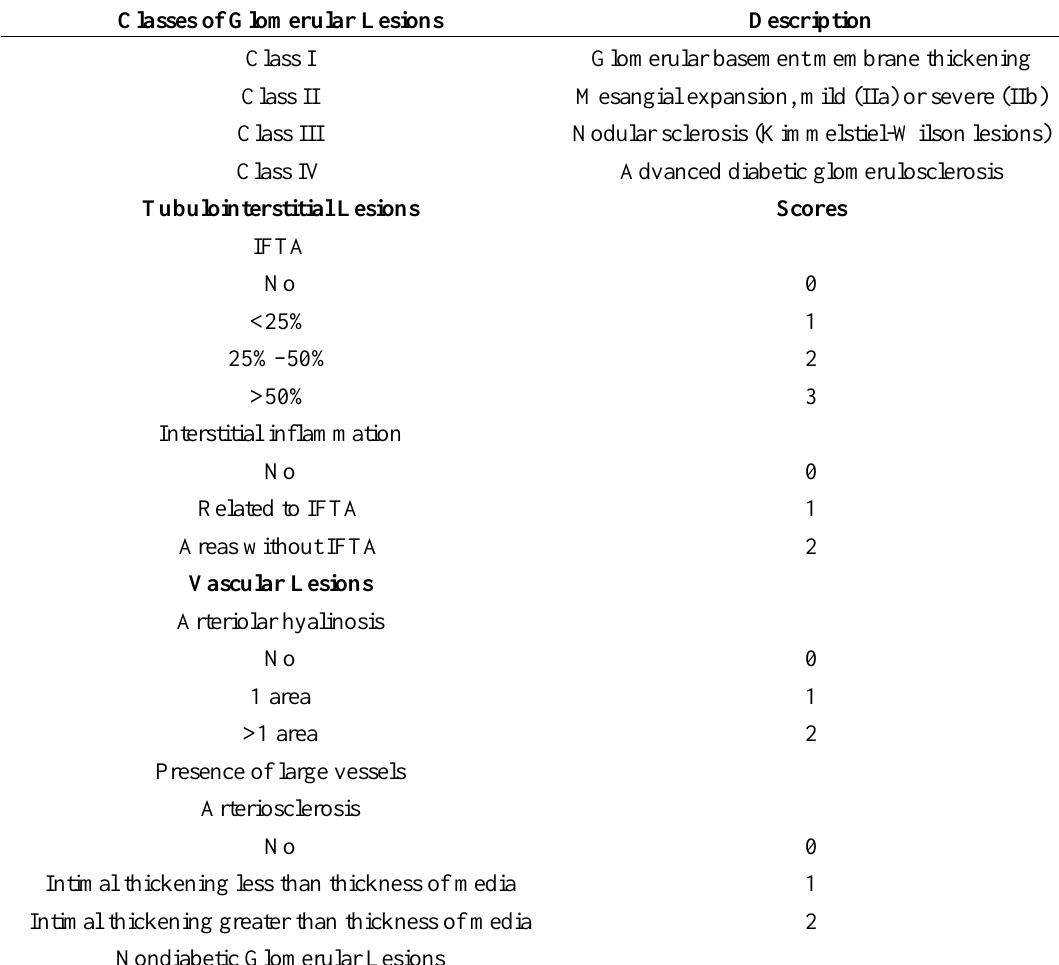
Table 1. Pathologic classification of diabetic nephropathy (modified from Tervaert el al.